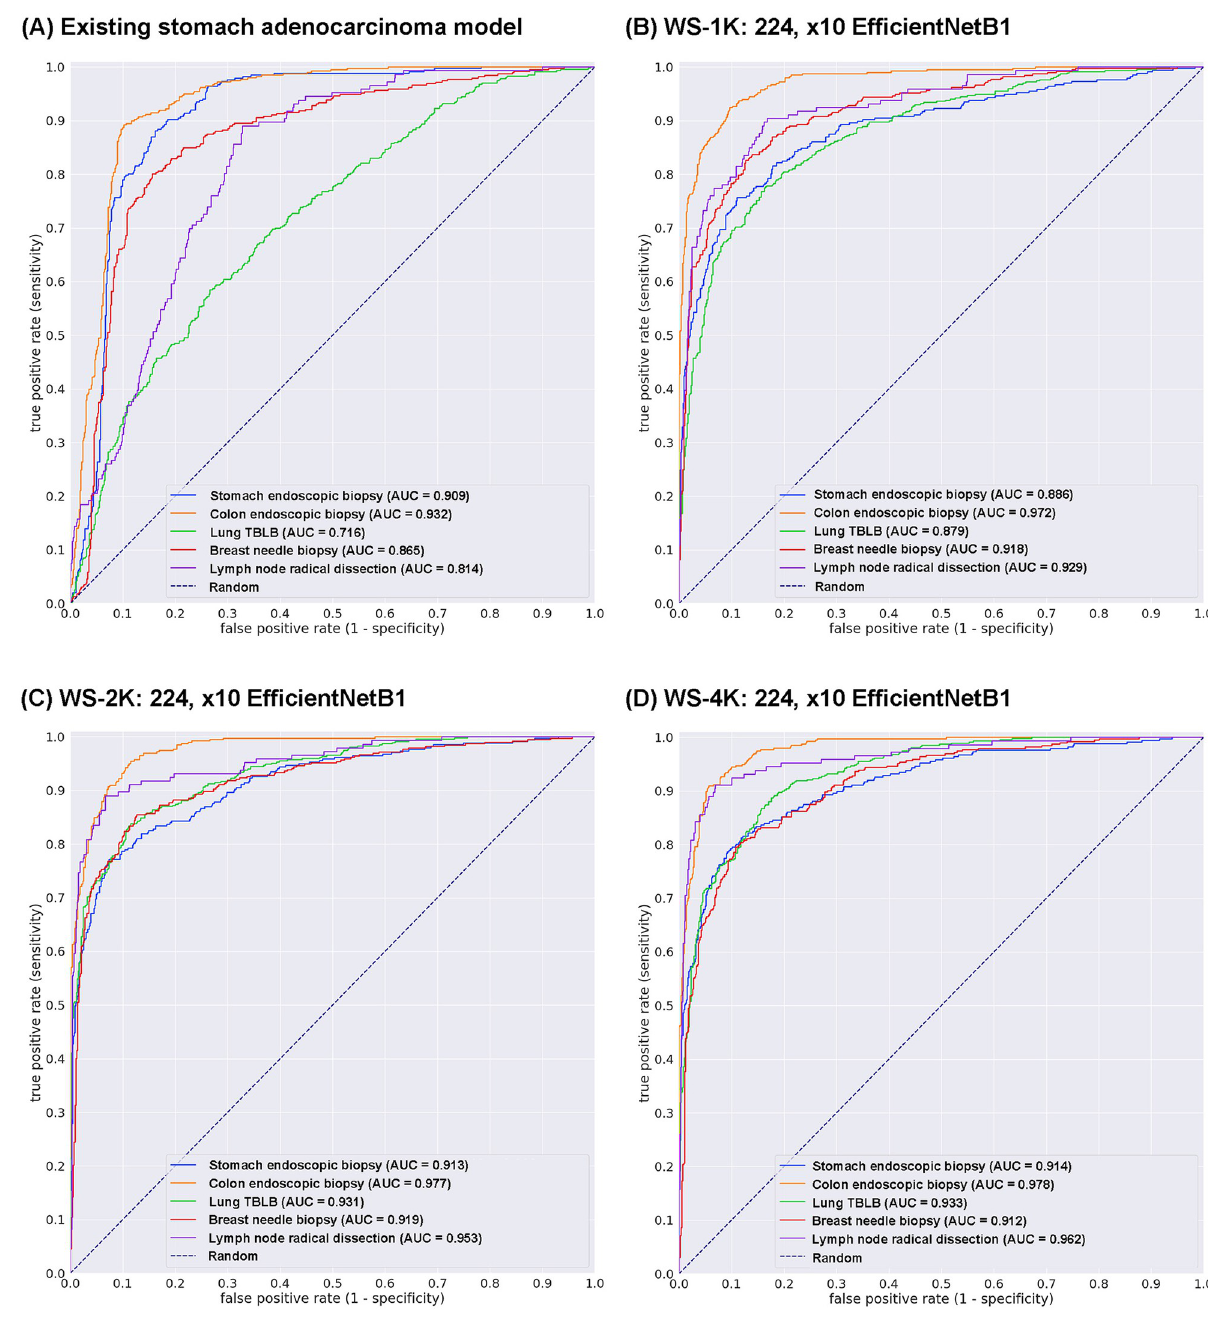
Fig 2. ROC curves with AUCs from four different models (A-D) on the test sets: (A) Existing stomach adenocarcinoma classification model and weakly supervised (WS) learning models based on 1K (B), 2K (C), and 4K (D) training sets with tile size 224 px and magnification at x10.